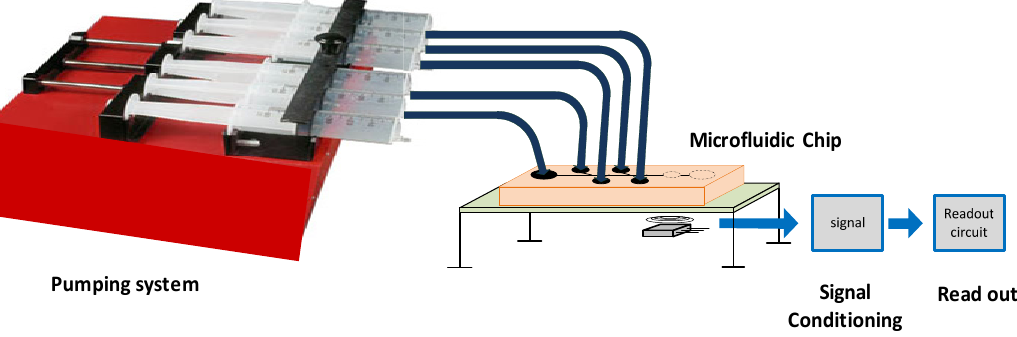
Figure 7. Testing platform with pump and sensor to perform immunoassay.